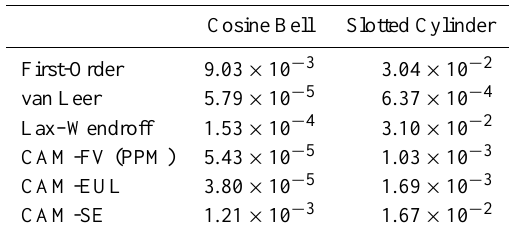
Table 1. Percentage of mass in the eastern hemisphere for test 4. Cosine Bell Slotted